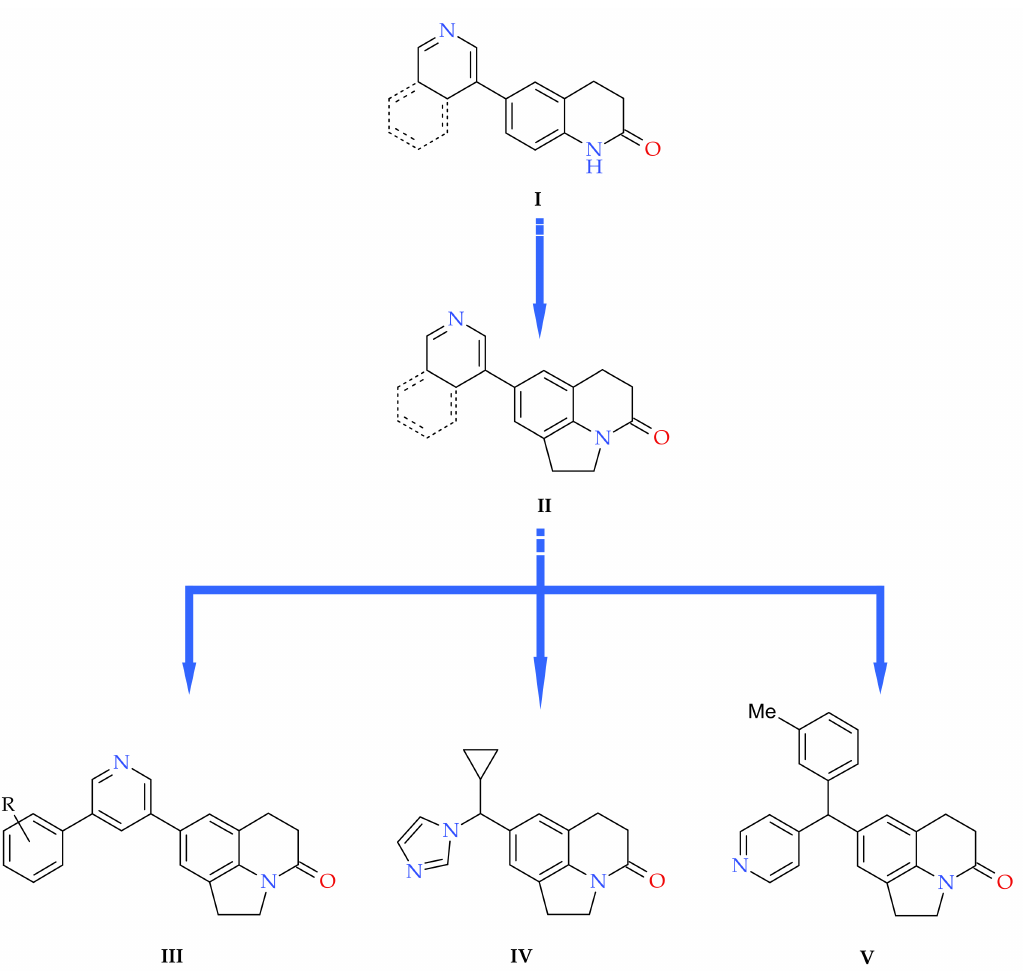
Figure 1. The stages of optimization for synthetic aldosterone synthase inhibitors of quinolone series [18–23].